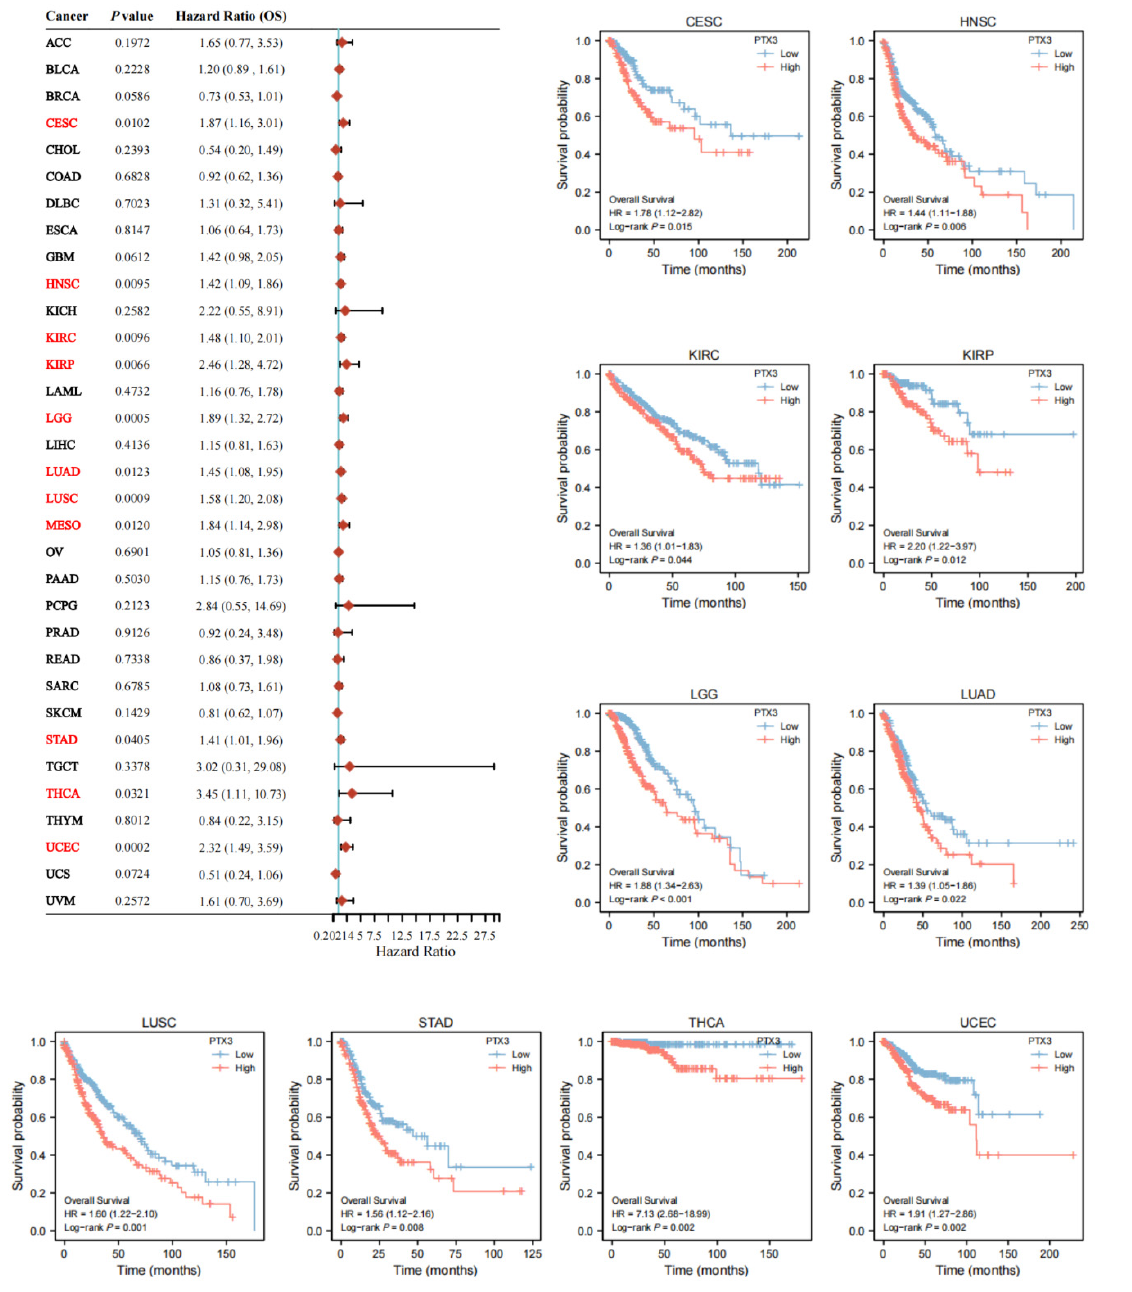
LGG (HR = 1.95, p = 0.0005), LUAD (HR = 1.48, p = 0.0395), LUSC (HR = 1.89, p =